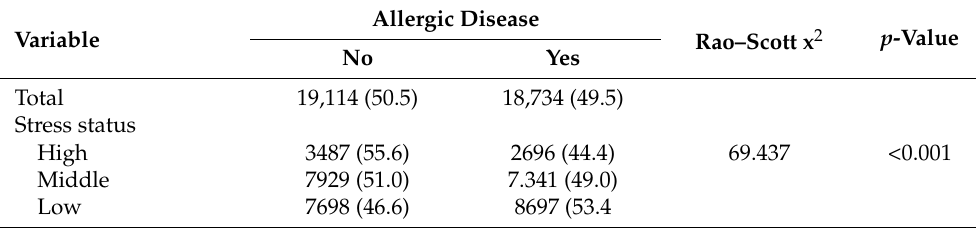
Table 2. Characteristics of health